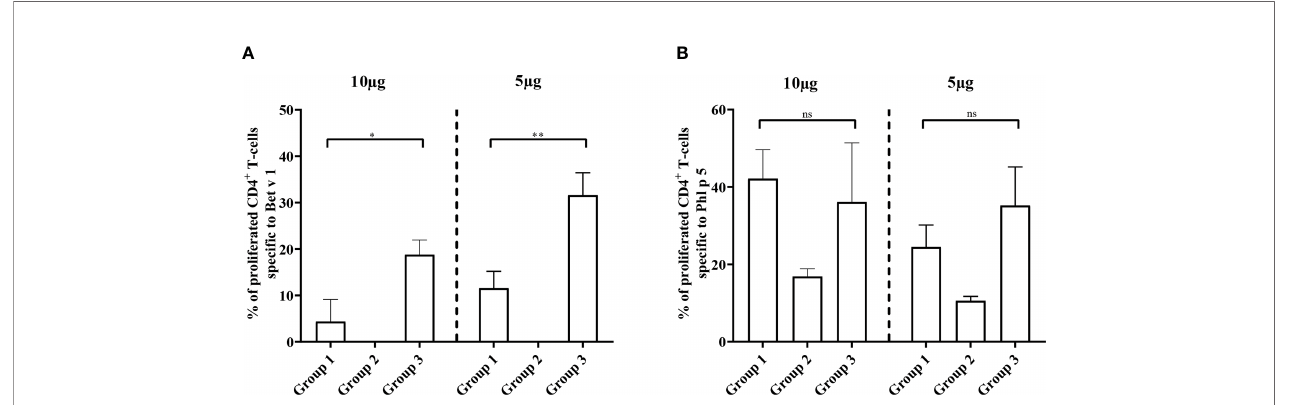
FIGURE 9 | Allergen-speci fi c T cell responses after prophylactic administration of Bet v 1 peptides. Pooled splenocytes from the three mouse groups were labelled with CFSE and cultivated in the presence of 10µg of Bet v 1 or 5µg of Bet v 1 (A) , 10µg of Phl p 5 or 5µg Phl p 5 (B) . T cell proliferative responses were analyzed by fl ow cytometry 5 days after initiation of culture and by gating on live CD3 + CD4 + T cells. Proliferated lymphocytes were assessed by loss of CFSE fl uorescence intensity. The experiments were performed in triplicates. Shown are the mean percentages of allergen-speci fi c proliferated CD4 + T cells after subtraction of the medium controls and SD. Data were analyzed by a general linear model with a log link, comparing group 1 and 3 by linear contrast. Statistically signi fi cant differences between group 1 and group 3 are indicated (**P < 0.01, *P < 0.05). ns, not signi fi cant.